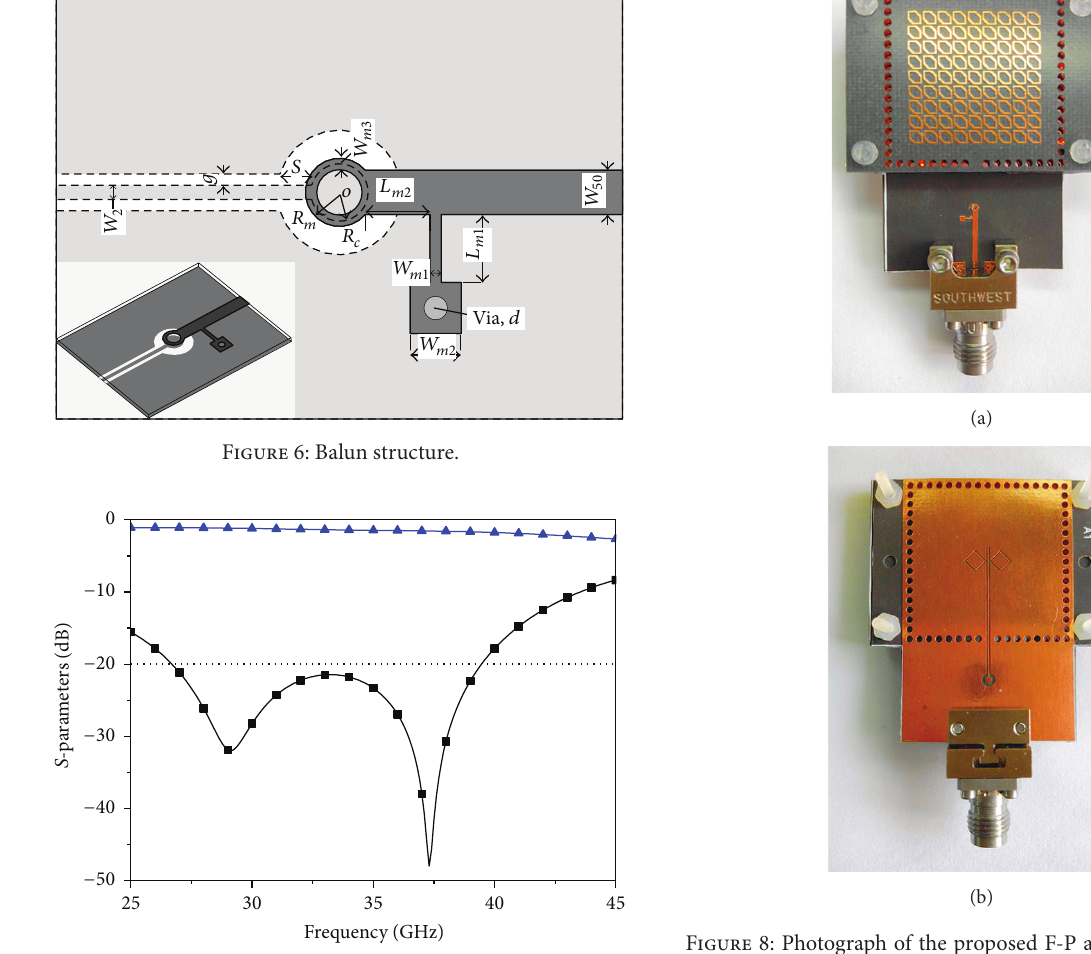
Figure 8: Photograph of the proposed F-P antenna. (a) Top view, (b) bottom